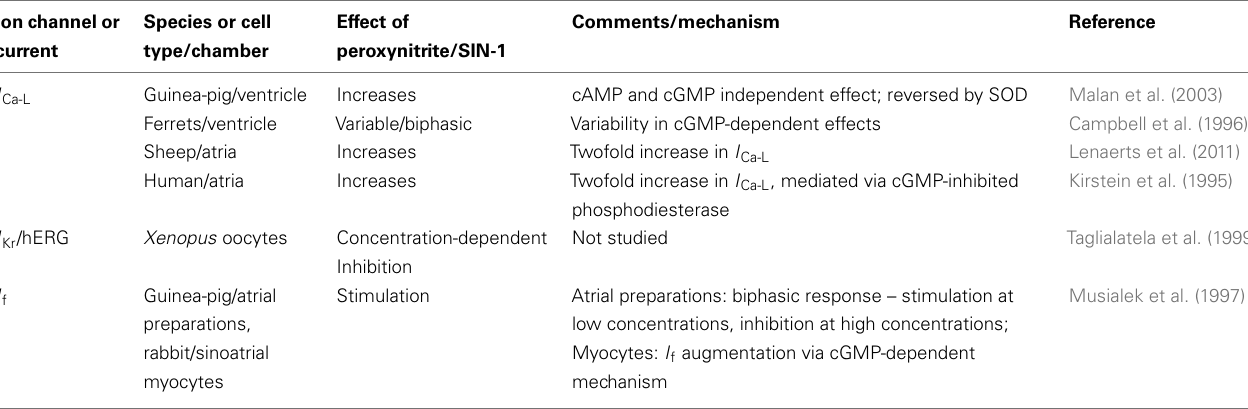
Table 2 | Electrophysiologic effects of